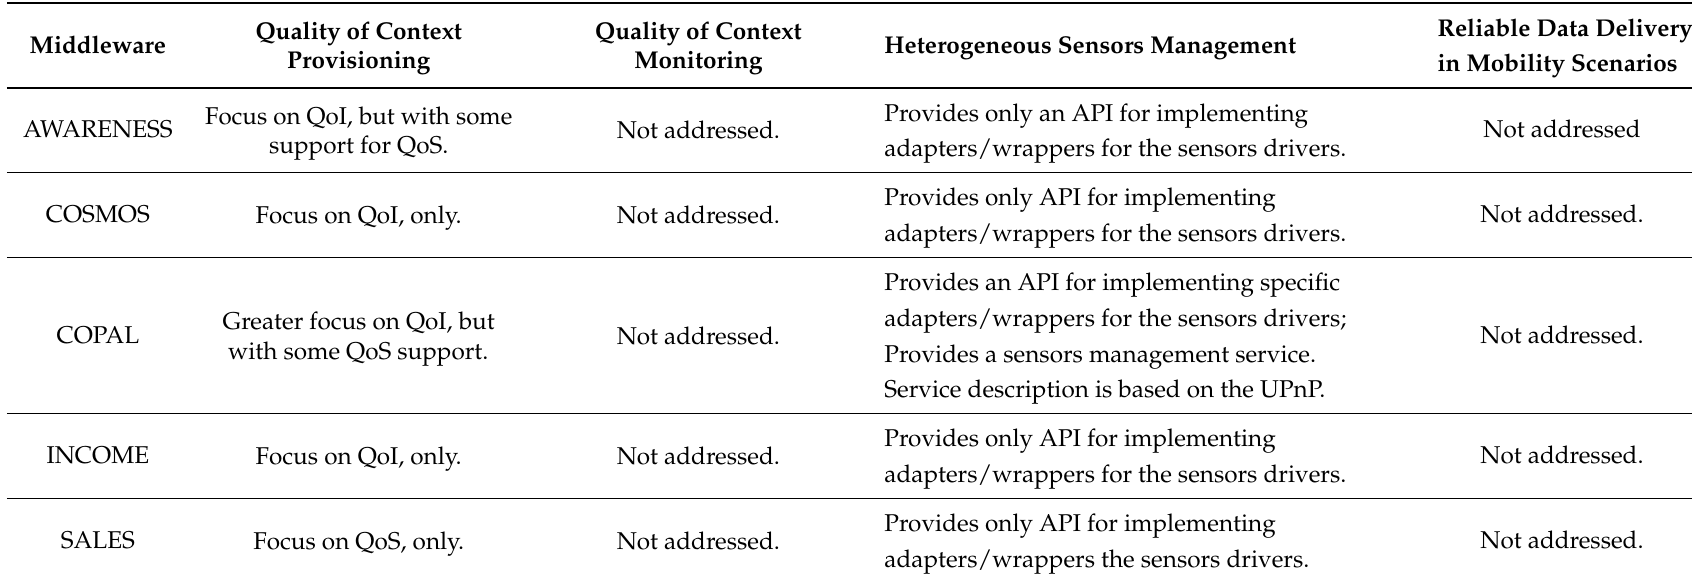
Table 1. Comparison between related work emphasizing the open research